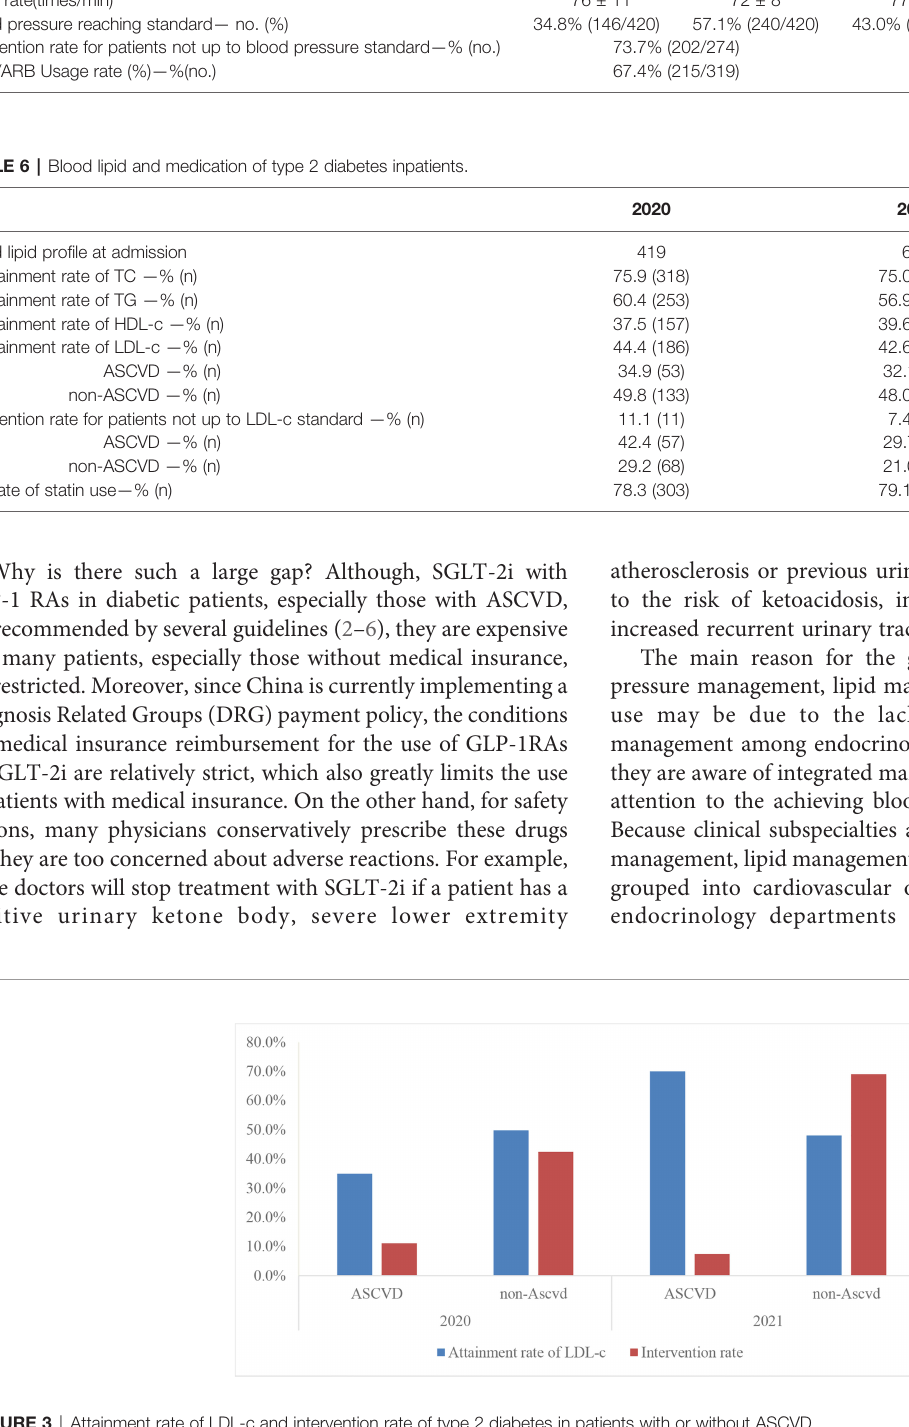
FIGURE 3 | Attainment rate of LDL-c and intervention rate of type 2 diabetes in patients with or without